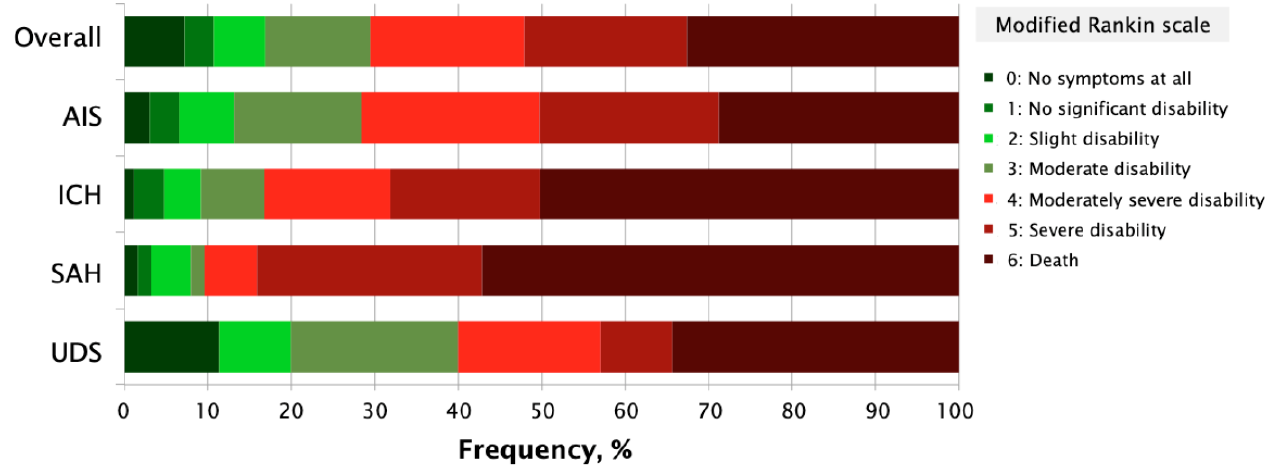
Figure 3. Functional outcome at 30-day follow-up by stroke subtype. ICH indicates intracerebral hemorrhage; AIS, acute ischemic stroke; mRS, modified Rankin scale; SAH, subarachnoid hemorrhage; and UDS, undetermined stroke.